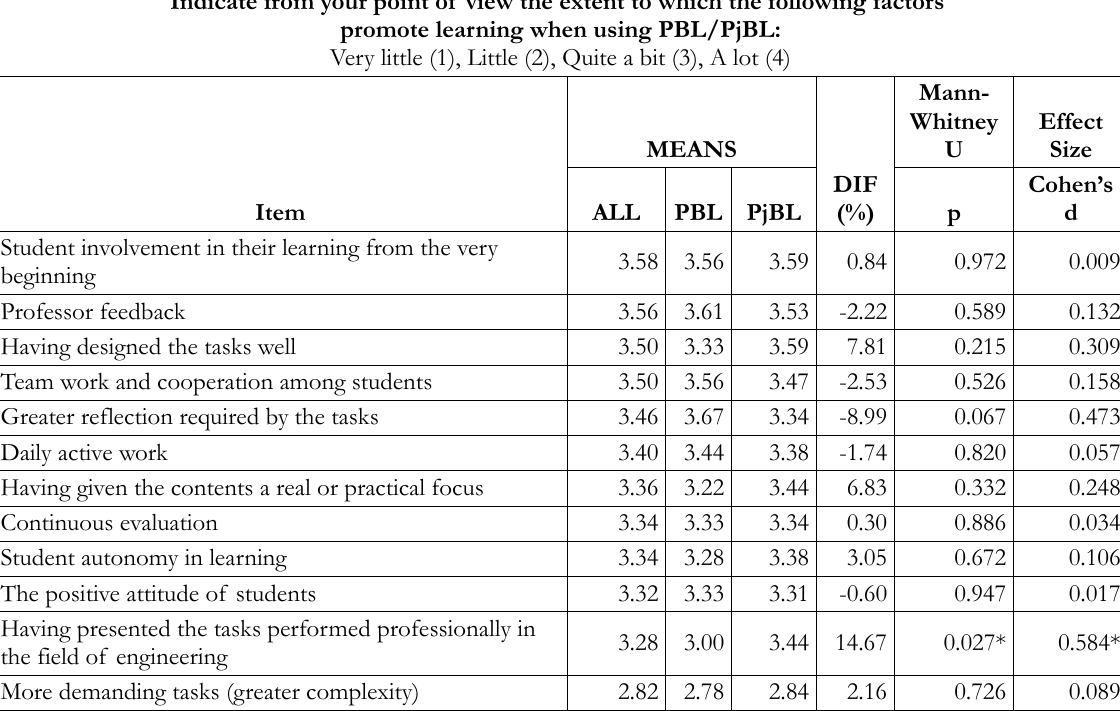
Table 3. Evaluation of the success factors that promote learning when using